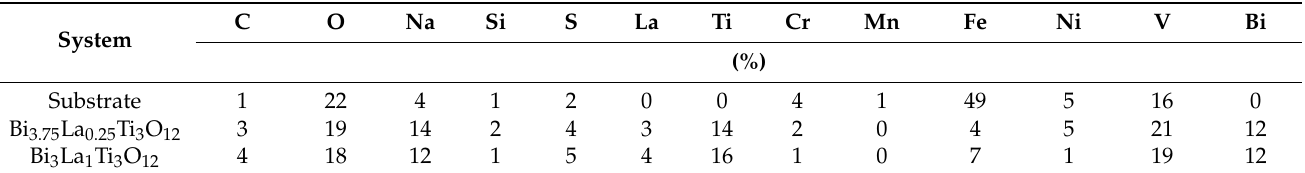
Table 7. Chemical analysis for Bi 3.75 La 0.25 Ti 3 O 12 and Bi 3 La 1 Ti 3 O 12 coatings and the substrate at a temperature of 850 ◦ C.